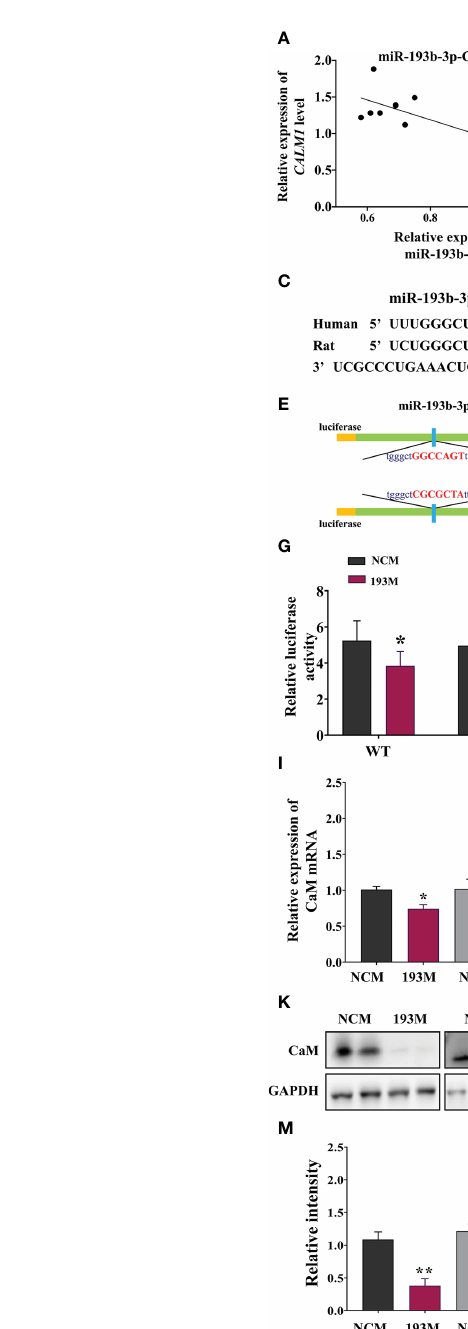
FIGURE 5 miR-193b-3p and miR-152-3p target CaM and CaMKII ɑ , respectively, by directly binding to 3 ′ -UTR. (A, B) Correlation between CaM mRNA and miR- 193b-3p (A) , as well as between CaMKII ɑ mRNA and miR-152-3p (B) , in the brains of 2VO rats. (C, D) Predicted binding sites of miR-193b-3p and CaM (C) and miR-152-3p and CaMKII ɑ (D) . (E, F) Construction of the Luc-CAM-WT and Luc-CAM-MUT (E) and Luc-CAMK2A-WT and Luc-CAMK2A- MUT (F) luciferase plasmids. (G) Relative luciferase activity for target validation of CaM. (H) Relative luciferase activity for target validation of CaMKII ɑ . (I) Expression of CaM mRNA after transfection with miR-193b-3p mimics/inhibitor. (J) Expression of CaMKII ɑ mRNA after transfection with miR-152- 3p mimics/inhibitor. (K, L) Representative Western blot bands of CaM (K) and CaMKII ɑ (L) . (M, N) Quantitative analysis of the ratios of CaM (M) and CaMKII ɑ (N) . Results represent the mean ± SD, n =4, * P <0.05, ** P <0.01, *** P <0.001 vs. NCM, # P <0.05, ## P <0.01 vs. NCI. NCI, Negative control inhibitor; NCM, Negative control